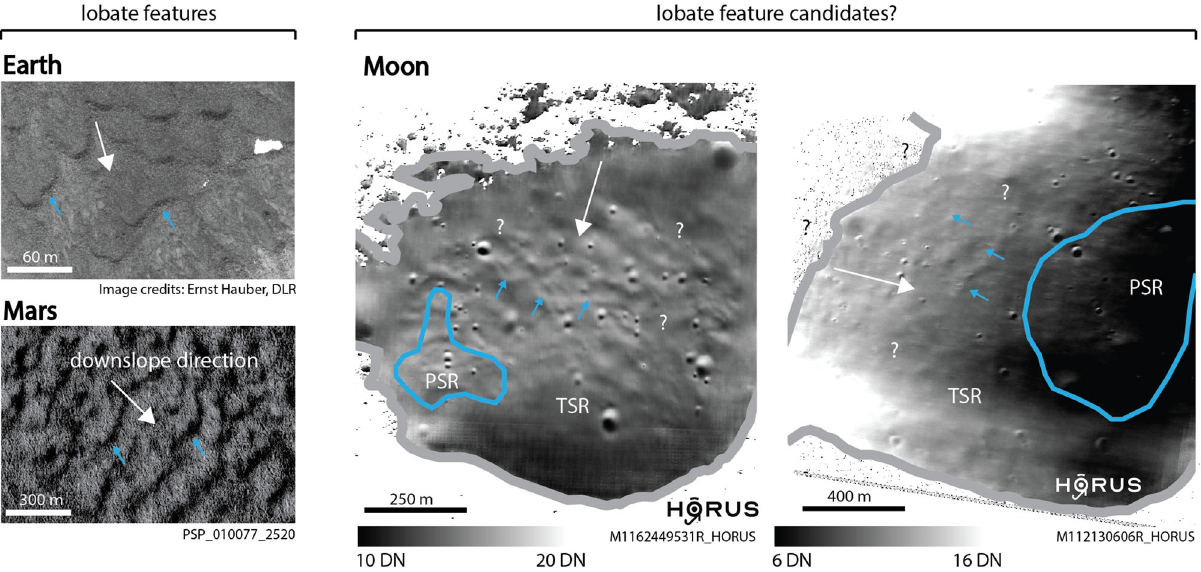
Fig. 7 Ice-related, geomorphic features on Earth and Mars — and the Moon? Examples of geomorphic expressions of ice-bearing soils, such as lobate features (soli fl uction lobes), found on Earth (here: High-Resolution Stereo Camera AX (HRSC-AX) image, Svalbard, Arctic Norway 50 ) and potentially on Mars (High-Resolution Imaging Science Experiment (HiRISE) image 51 ). Lunar TSRs (transiently shadowed regions) might potentially host similar geomorphic features, as indicated on the right-hand side (the boundary of the NAC-observed (Narrow Angle Camera) TSR is indicated in gray; the PSR (permanently shadowed region) boundary is indicated in blue, selected lobate-type features are indicated by blue arrows, for A102 PSR 5-left and A011 PSR 1-right). The local slope is indicated with a white arrow. HORUS images have been contrast stretched to highlight the candidate features; the range of digital numbers (DN) is shown at the bottom of the fi gure. HRSC-AX image credits to Ernst Hauber (DLR); HiRISE image credits to NASA/JPL/UoA; raw NAC image credits to